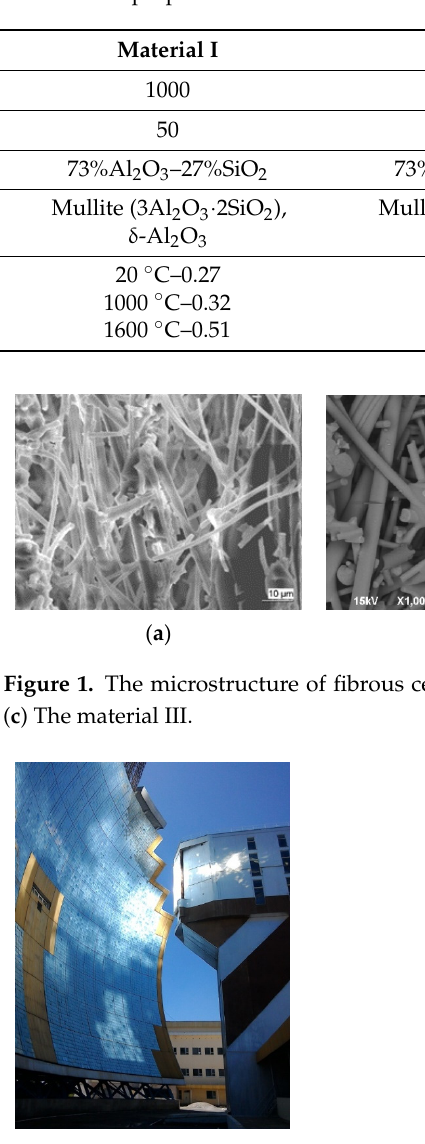
Figure 2. The solar concentrator and the technological tower of the Big Solar Furnace.